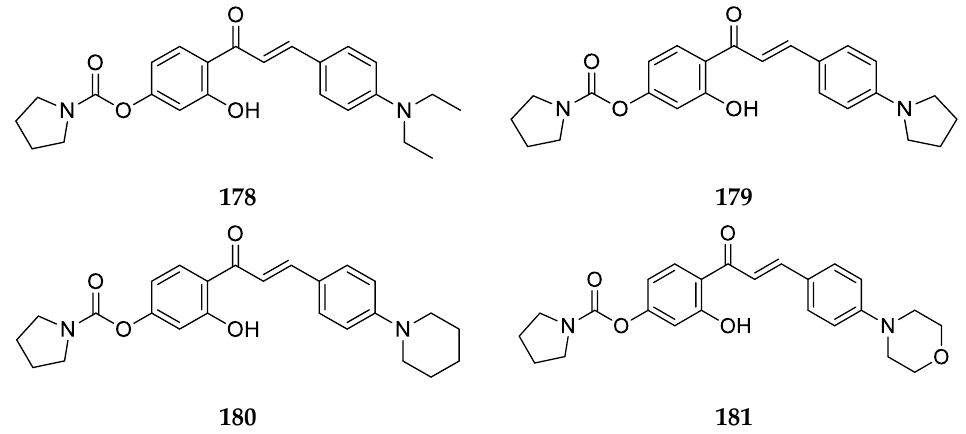
(cid:48) -aminochalcone